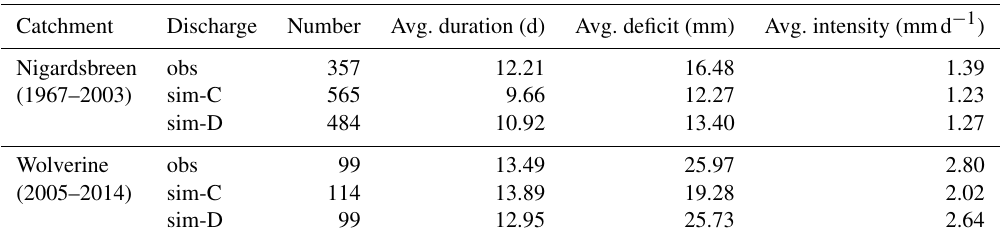
Table 2. Streamflow drought characteristics of observed and simulated discharge. Drought characteristics are shown for observed discharge (obs) and simulated discharge (sim) with constant (C) and dynamic (D) glacier area conceptualisation in the calibration period of Nigards- breen and Wolverine.